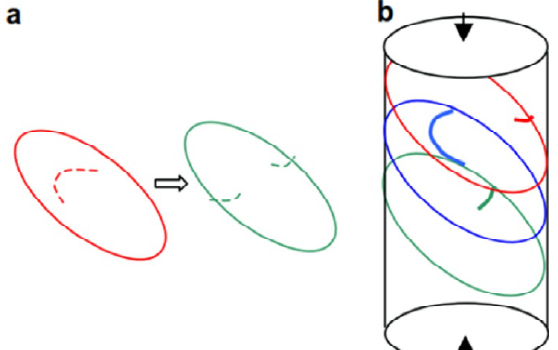
Fig. 17. (a) A schematic description of changing a double-pinned Frank–Read sources to single arm sources in a small volume. (b) Representation of